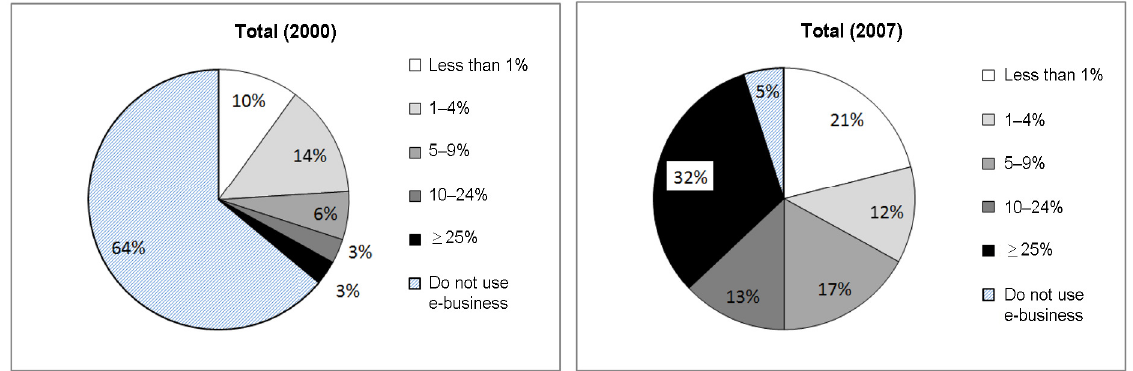
Fig. 2. Proportion of turnover (2000, left) and purchase (2007, right), in workplaces where some e-business have been